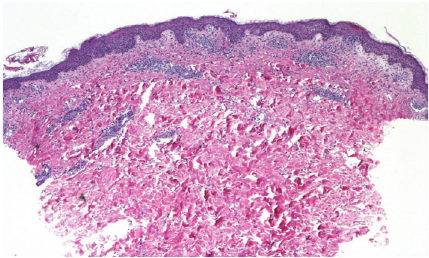
Figure 1: A moderate superficial perivascular infiltration of lym- phocytes with some eosinophils and some papillary dermal edema.